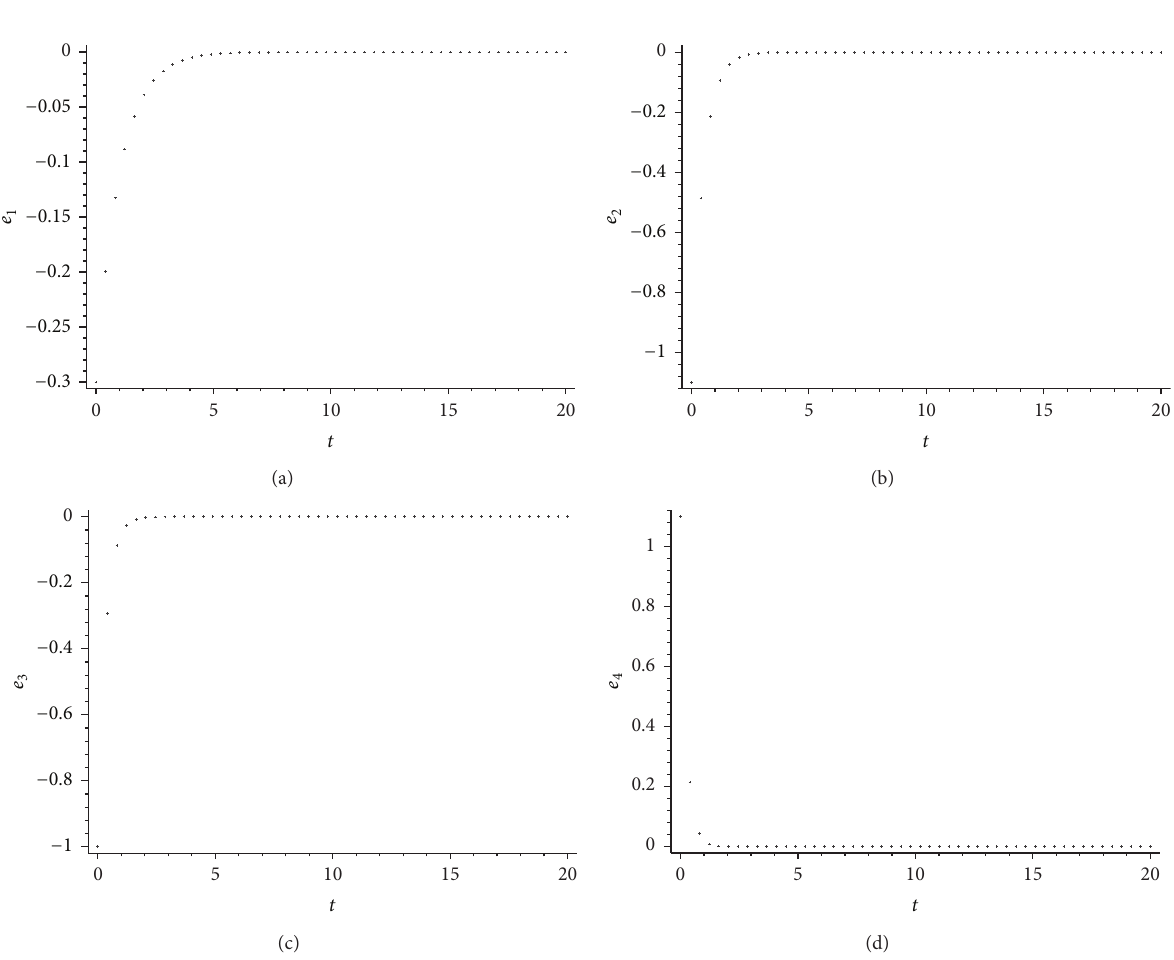
Figure 14: The dynamics of synchronization errors. (a) Signal 𝑒 1 , (b) signal 𝑒 2 , (c) signal 𝑒 3 and (d) signal 𝑒 4